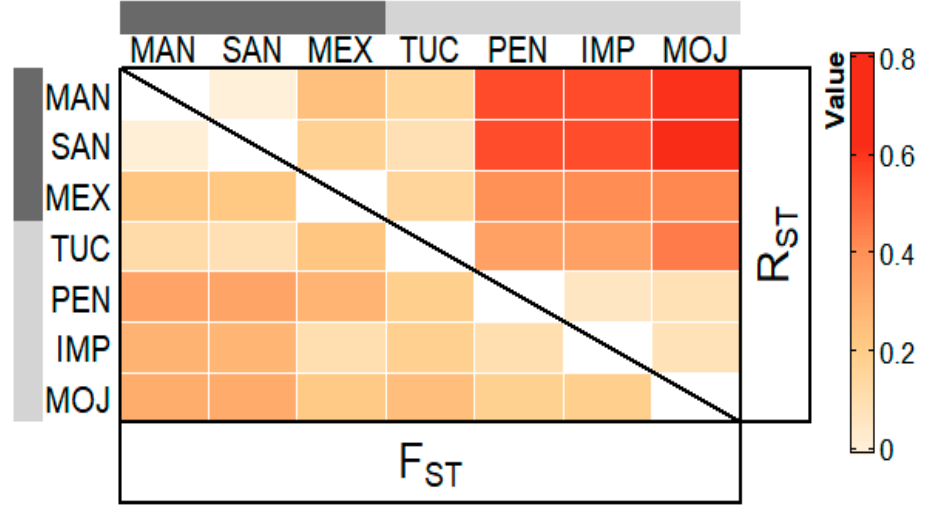
Figure 2. Heat map of the pairwise F ST values (above the diagonal) and the pairwise R ST values (below the diagonal) for the three wild and four farmed populations of Arapaima gigas , estimated by microsatellite data.